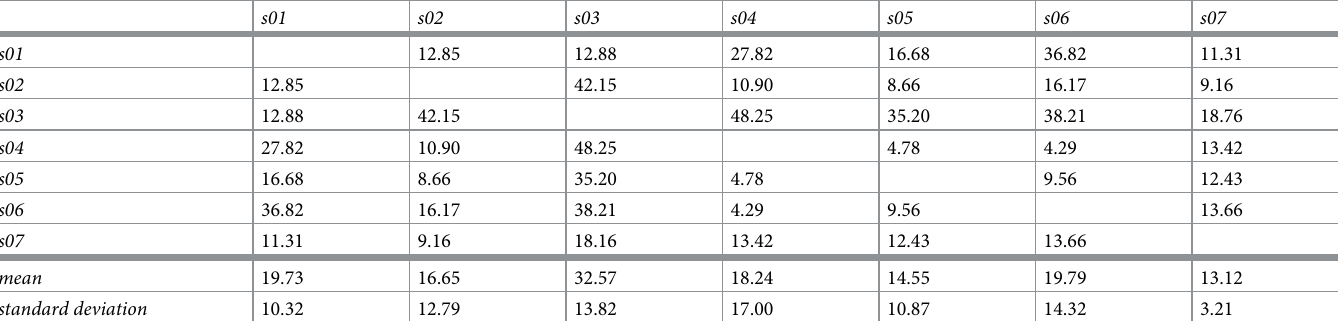
Table 3. Distance alignment values for the smileFrown controller for the open-mouth smile